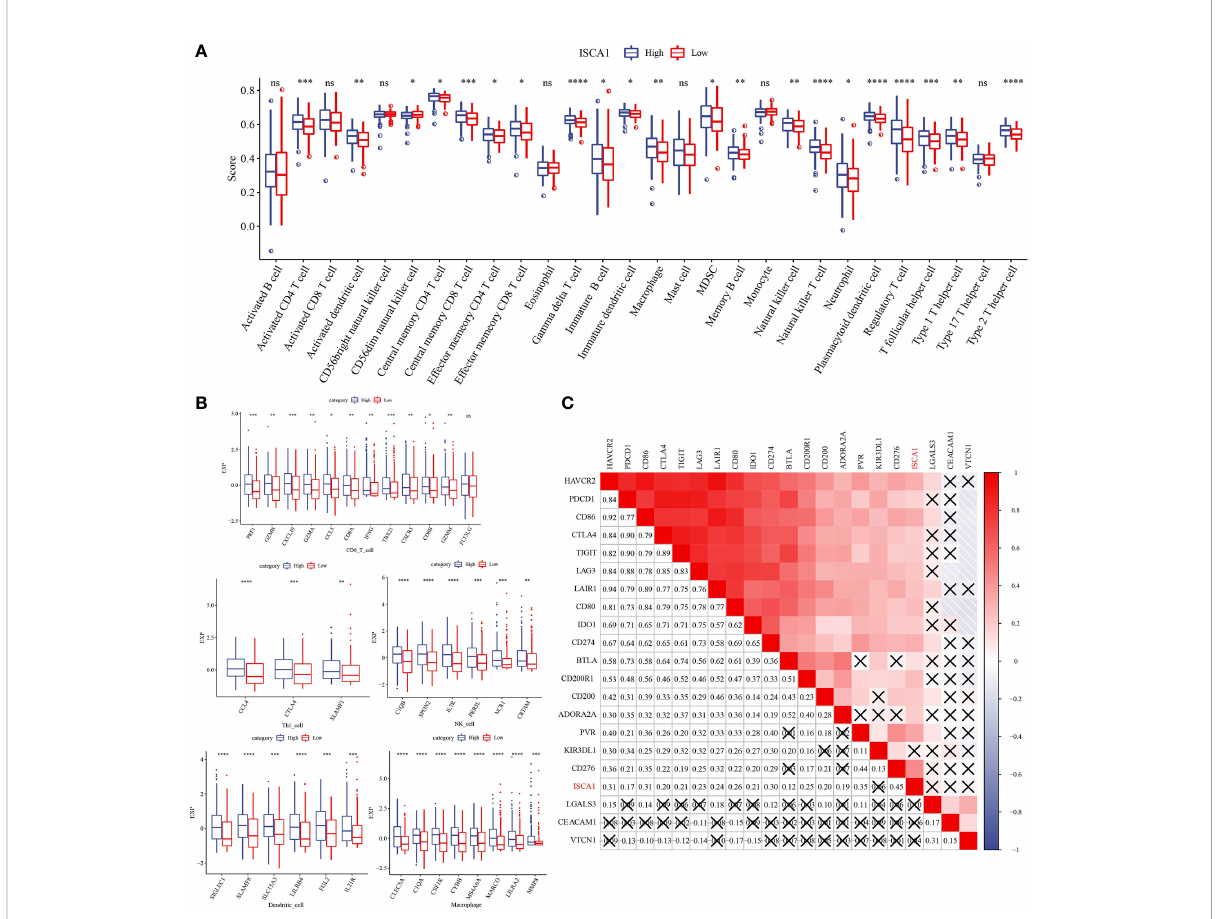
FIGURE 5 Distribution difference of immune cell score in ISCA1 group. (A) Differences in immune cell score between high ISCA1 group and low ISCA1 group. (B) Differences in effector genes of fi ve TIICs (cd8+t cells, NK cells, macrophages, Th1 cells, and dendritic cells) related immune cells between the high ISCA1 group and low ISCA1 group. (C) Correlation between ISCA1 and immune checkpoints. Color and value represent Spearman correlation coef fi cient. (X represents p>0.05) (* represents p < 0.05, ** represents p < 0.01, *** represents p < 0.001, **** represents p < 0.0001, ns represents p >